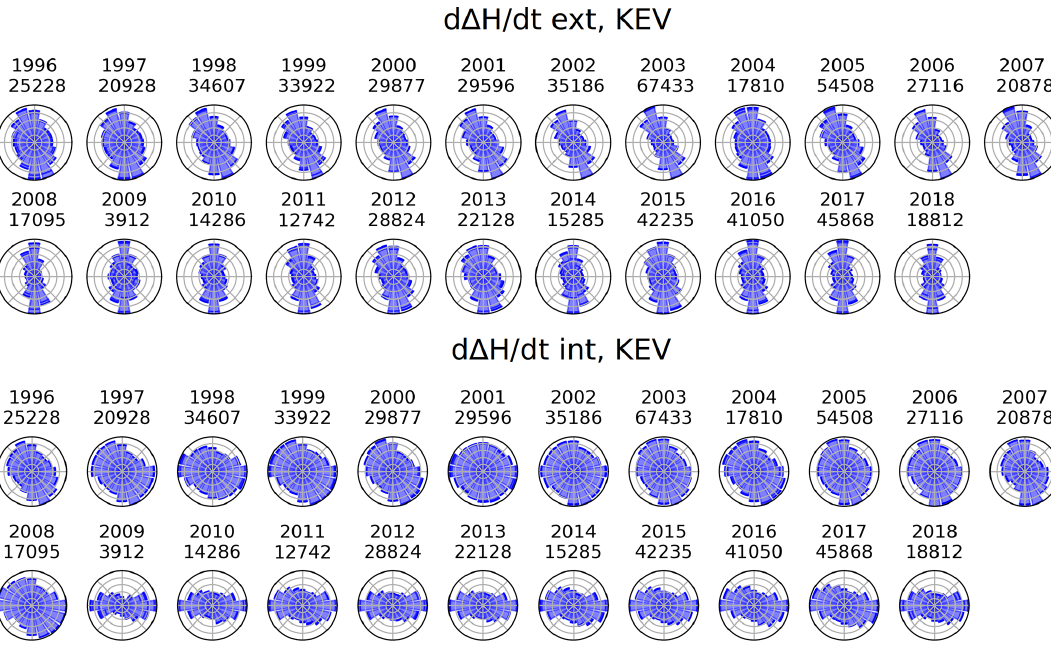
Figure A1. Yearly directional distributions of d (cid:49) H / d t at Kevo (KEV), 1996–2008. Upper panel: external d (cid:49) H / d t ; lower panel: internal d (cid:49) H / d t . The number of data points is plotted under the year label.